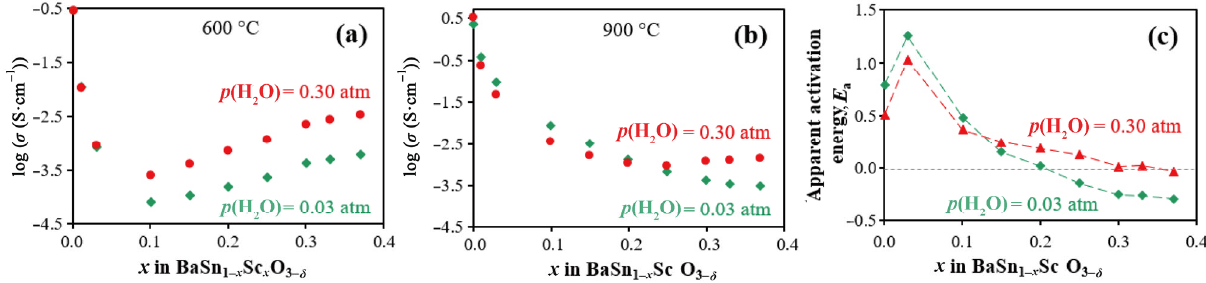
Fig. 7 Concentration dependencies of σ for the BaSn 1 − x Sc x O 3 − δ ceramic samples at various p (H 2 O) in hydrogen in (a) low- temperature and (b) high-temperature ranges; (c) the corresponding E a in the temperature range of 500–700 ℃